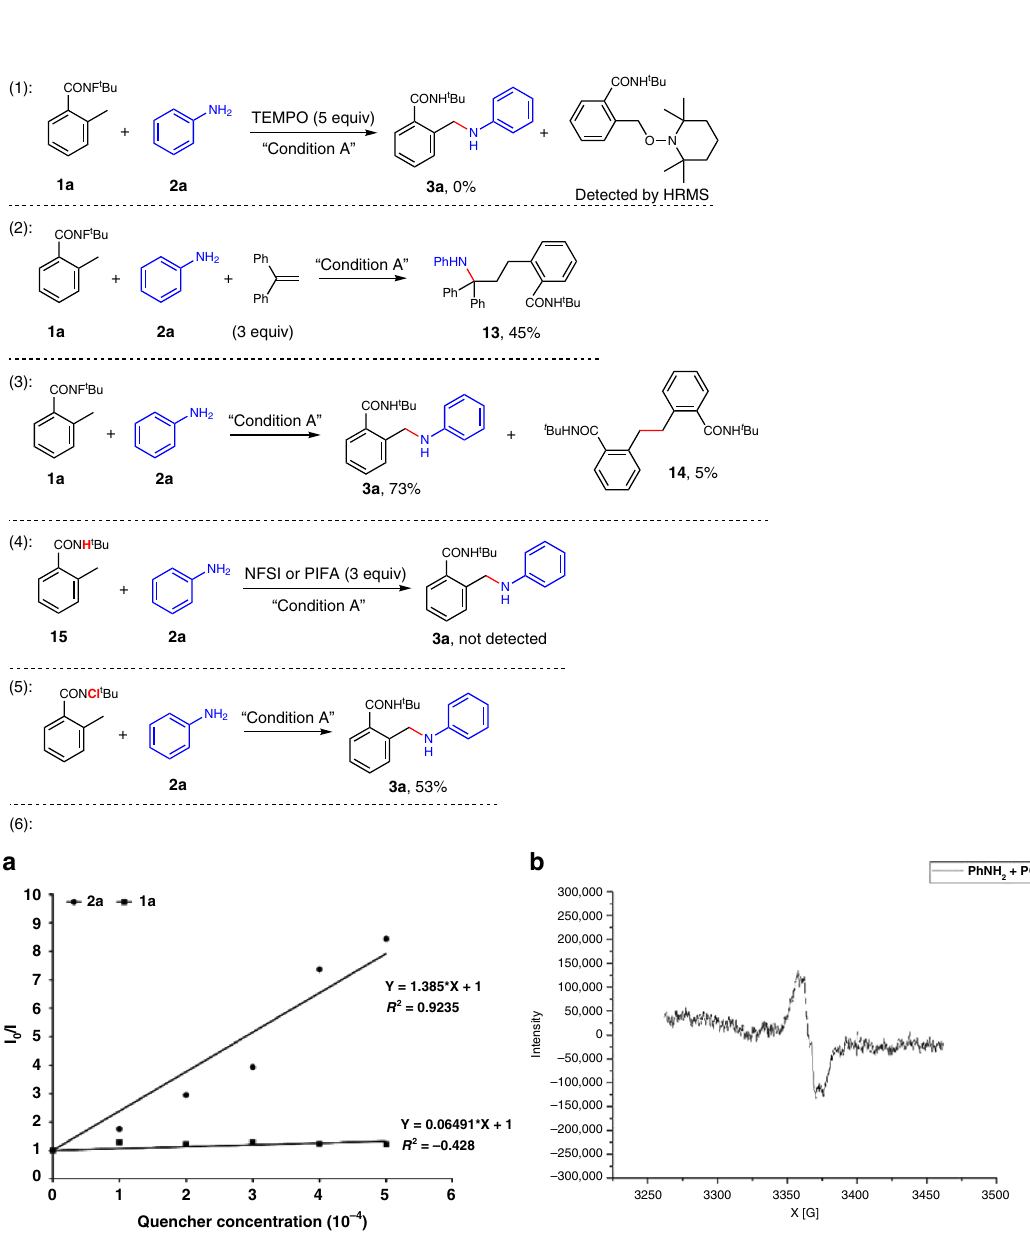
Fig. 8 Mechanistic studies. Equation (1) Radical trapping reaction with TEMPO. (2) Radical trapping reaction with ethane-1,1-diyldibenzene. (3) Homo- coupling product. (4) The results under oxidative conditions. (5) The result with N -chloroamide substrate. (6) ( a ) Fluorescence quenching of Ir (ppy) 2 (dtbpy)PF 6 by 2a and 1a . ( b ) EPR experiment result of PhNH 2 ( 2a , PhNH 2 (0.1 mmol) and Ir(ppy) 2 (dtbpy)PF 6 (5 mol%) in hexa fl uoroisopropanol (1 ml), stirred at room temperature for 1 h under 400-nm irradiation, and directly used for EPR